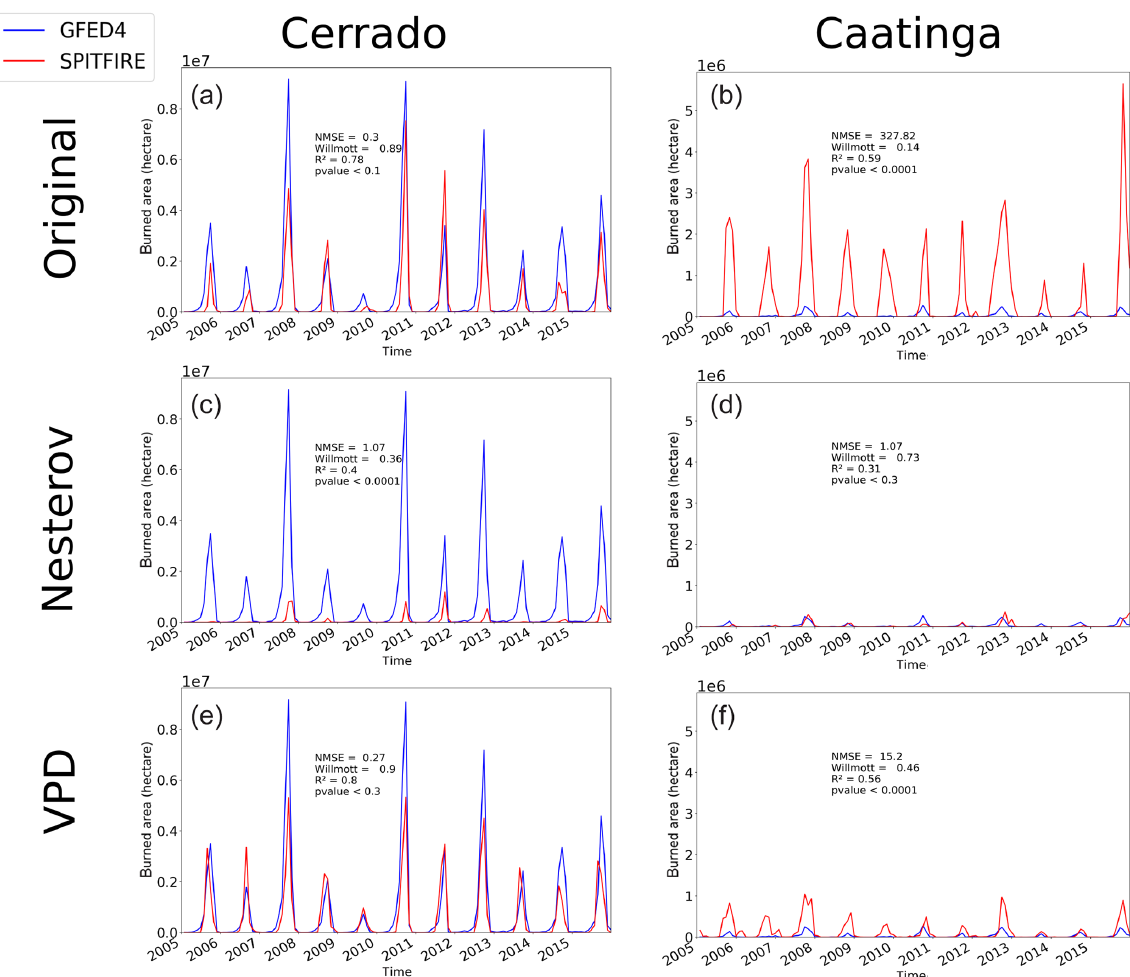
Figure A6. Time series of monthly burned area from 2005 to 2015 simulated by SPITFIRE (red lines) compared to GFED4 evaluation data (blue lines) for (a) the Cerrado region using NI orig , (b) the Caatinga region using the NI orig , (c) the Cerrado region using NI optim , (d) the Caatinga region using NI optim , (e) the Cerrado region using VPD optim , and (f) the Caatinga region using VPD optim